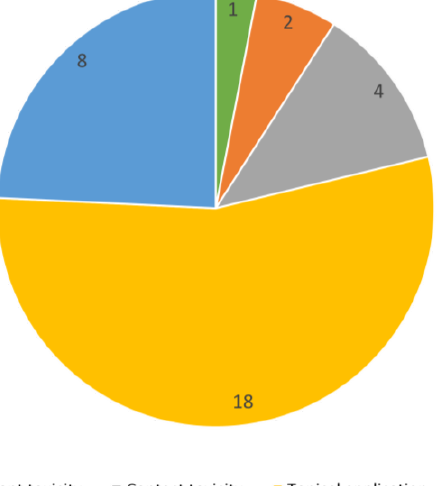
Figure 3. Methods used to test the insecticidal effect of EOs against Spodoptera frugiperda . The numbers represent the number of occurrences in the literature.